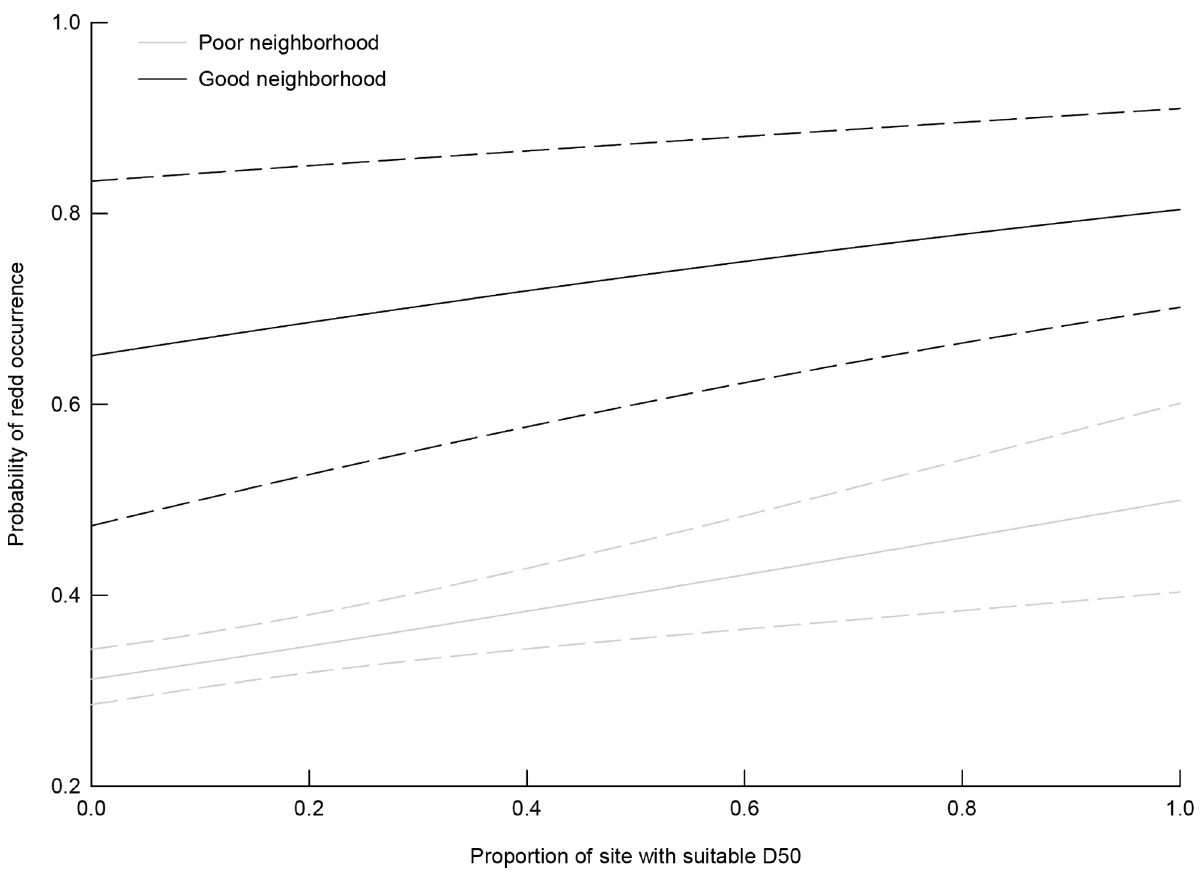
Figure 4. Probability of steelhead redd occurrence as a function of the proportion of a spawning survey site with suitable spawning substrates (D50 SITE ), in two neighborhood types : 1) Good has high amounts of suitable substrate in nearby reaches; and 2) Poor has low amounts. Estimates are from a hurdle count regression model. Dashed lines are 95% confidence intervals.